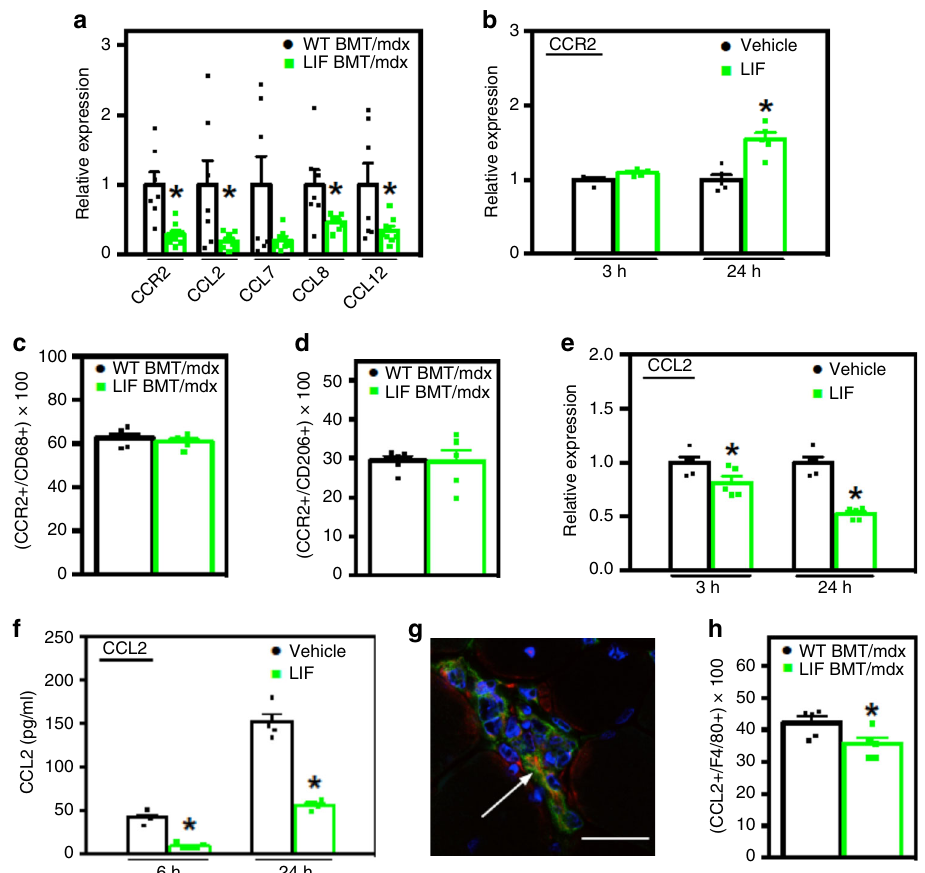
Fig. 4 Transplantation of CD11b/LIF transgenic BMCs disrupts Ccl2 expression in dystrophic muscles by inhibiting macrophage expression of CCL2. a QPCR analysis shows that TA muscles from LIF BMT/ mdx recipients have reduced expression of Ccr2 and its ligands Ccl2 , Ccl7 ( P = 0.06), Ccl8 , and Ccl12 . N =